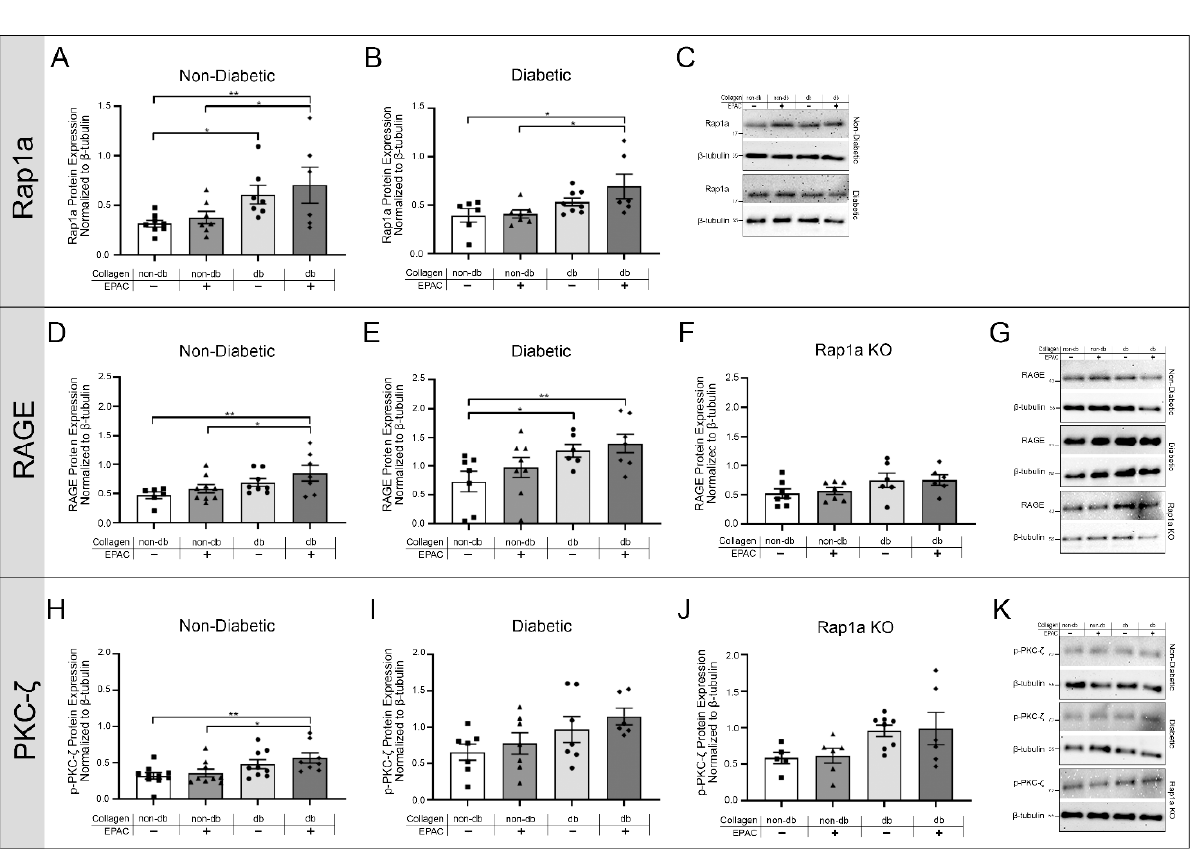
Figure 3. Exposing fibroblasts to AGEs in diabetic collagen and EPAC increased expression of RAGE-associated signaling proteins. Cardiac fibroblasts (P1) isolated from non-diabetic, diabetic, and Rap1a KO mouse hearts were cultured on either non-diabetic or diabetic collagen. Fibroblasts were either left untreated or treated with EPAC for 24 h (100 µM). Total protein was used to assess changes in AGE/RAGE-associated proteins. ( A - C ) Rap1a (21 kDa), ( D - G ) RAGE (46 kDa), and ( H - K ) p-PKC- ζ (72 kDa) protein expression was determined in non-diabetic, diabetic, and Rap1a KO fibroblasts. Protein expression was normalized to β -tubulin (55 kDa). Mean ± SEM was depicted on the graphs ( n = 6–10). ( C , G , K ) Representative Western blot images for Rap1a, RAGE, and p-PKC- ζ are depicted. Statistical analysis consisted of one-way ANOVA followed by a Fisher’s Protected Least Significant Difference post hoc (* p < 0.05 and ** p < 0.01).